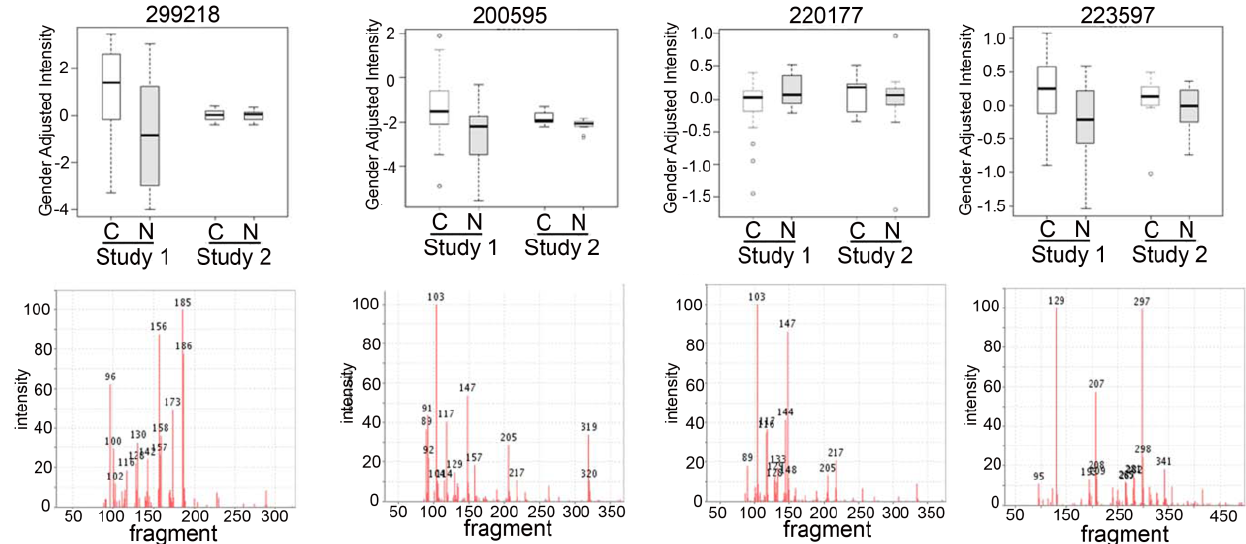
Figure 3. Box plots of top unknown compounds with electron ionization mass spectra comparing the two studies. Box-whisker plots (top panels) of the top unknown candidates from each study (Study 1 and Study 2) with the electron ionization MS spectra (lower panels) of the compound to show the mass fragmentation of the compounds to help with the identification of the